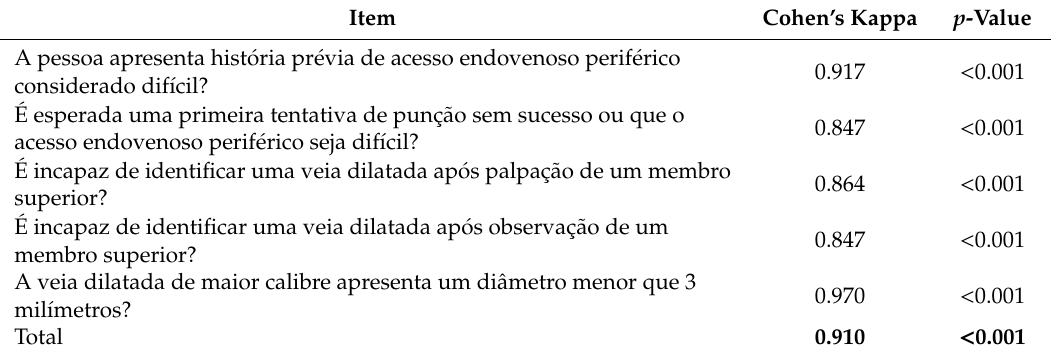
Table 3. Results of the inter-rater reliability analysis performed for the escala A-DIVA Modificada ( n = 200). Item Cohen’s Kappa p